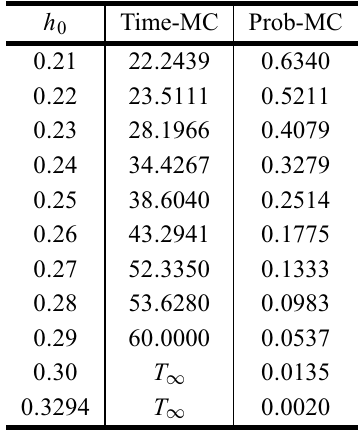
EstimatesoftheindicatorsbyMarkovchain as function of maximum slaughter